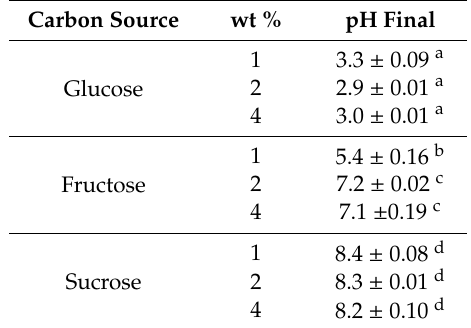
Table 1. Final pH value of growth HS media using di ff erent carbon sources, after seven days